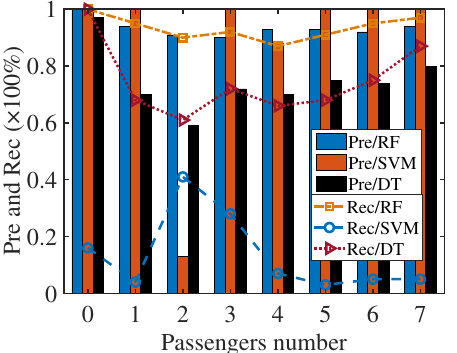
Figure 9. Performance comparison of different classifiers.